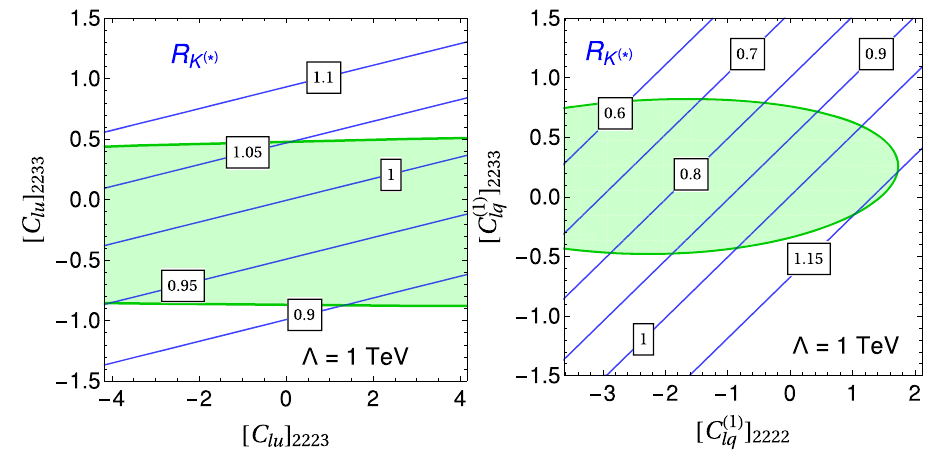
(right panel) coupled to lq